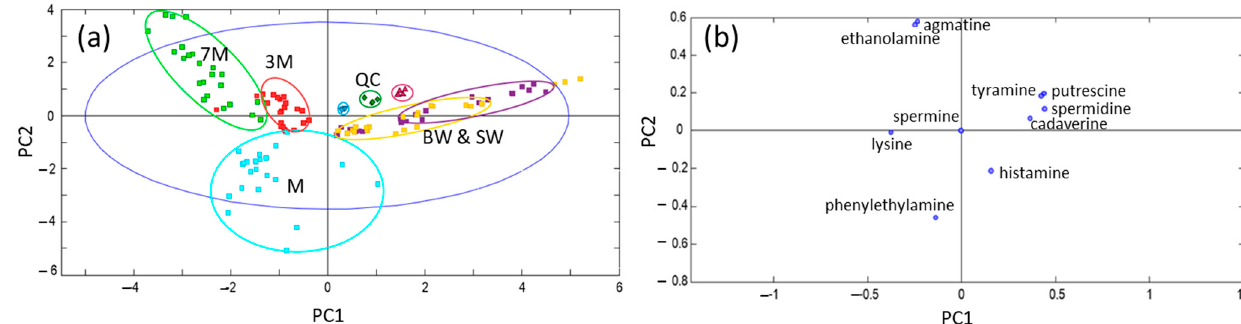
Figure 4. Characterization of product samples by PCA using the compositional profiles of amines as the data. ( a ) Scatter plot of scores of PC1 vs PC2; ( b ) Scatter plot of loadings of PC1 vs PC2. Sample assignment: M = must (light blue); BW = base wine (light ochre); SW = stabilized wine (purple); 3M = sparkling wine of 3 months aging (red); 7M = sparkling wine of 7 months aging (green); QC = quality control.